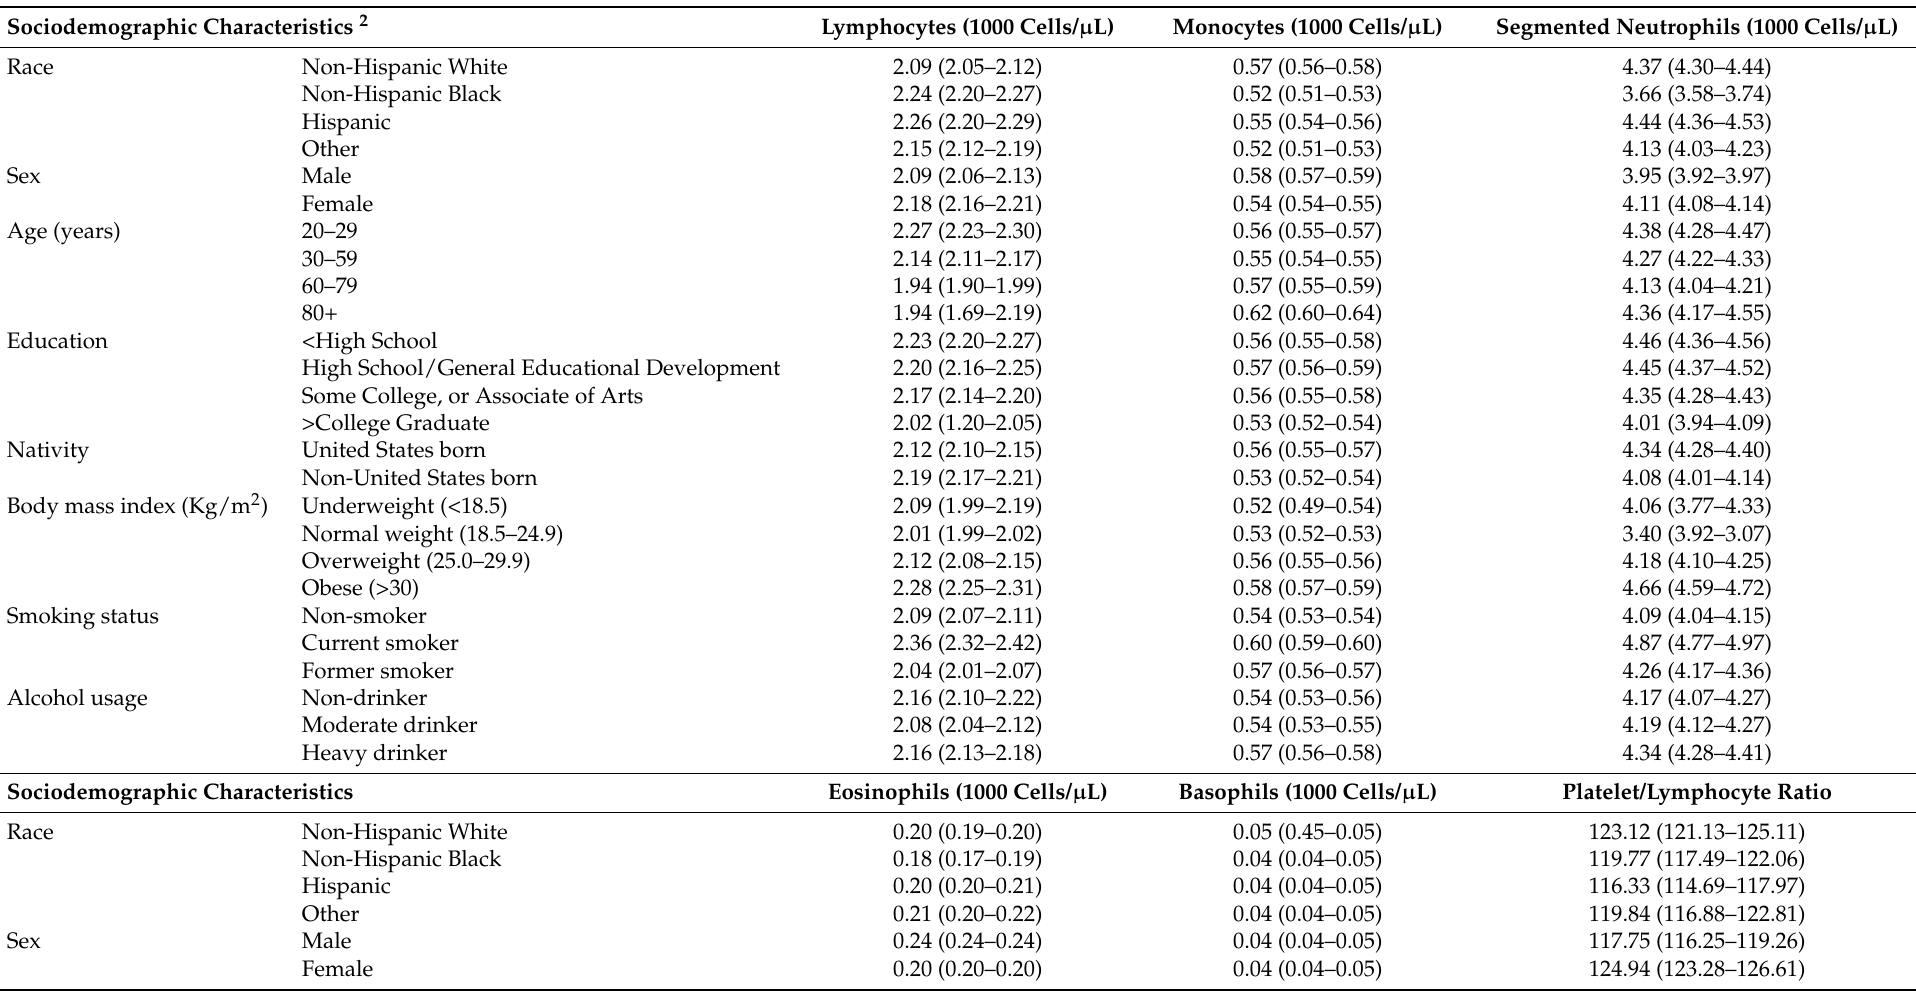
Table 2. Univariate associations of sociodemographic characteristics with clinical inflammatory markers: NHANES 2009–2016. Sociodemographic Characteristics